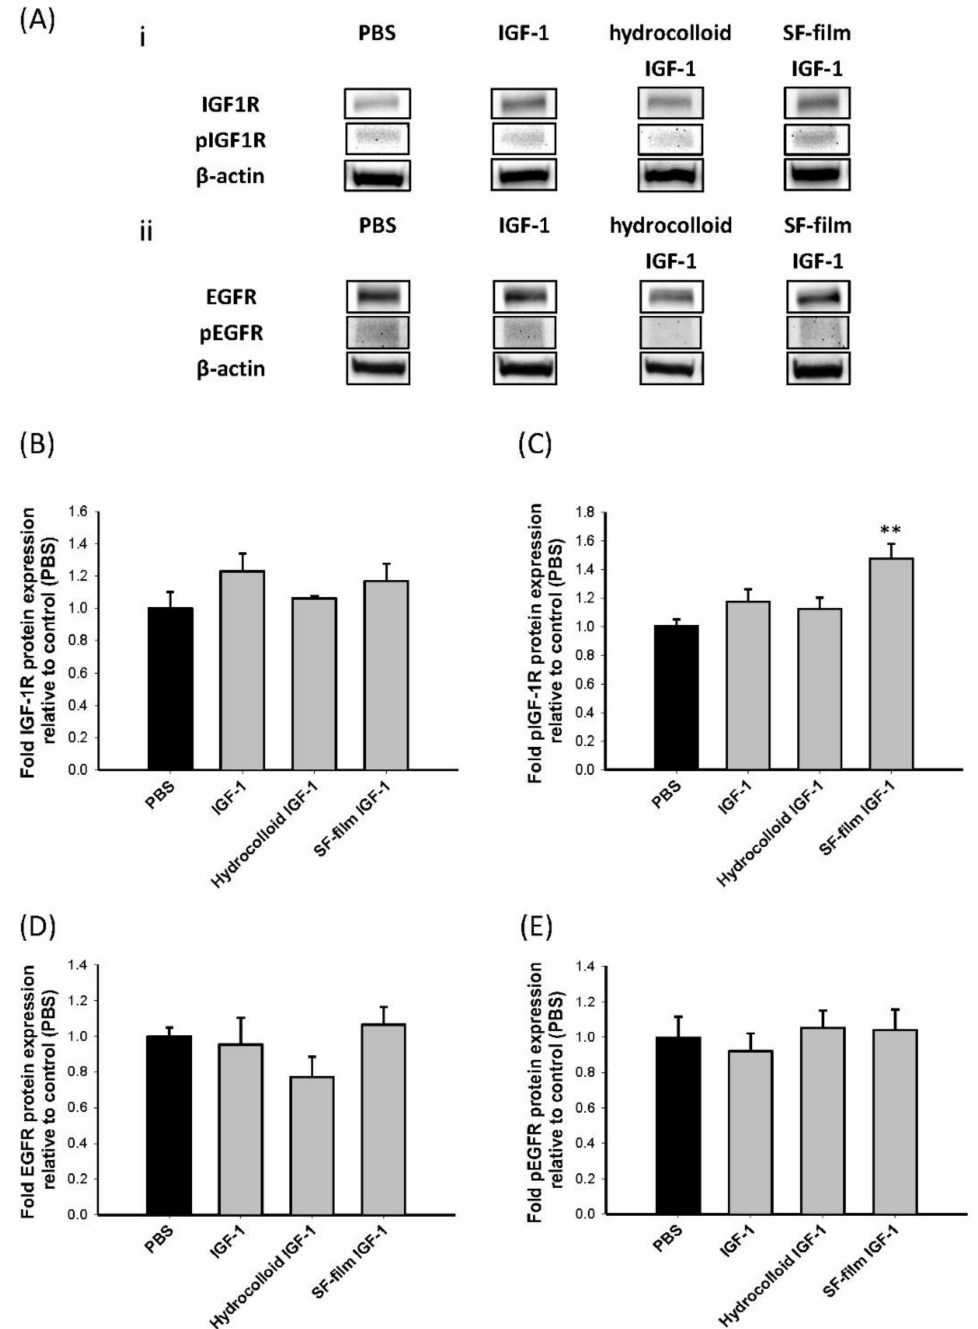
Figure 7. Immunoblotting for insulin-like growth factor type 1 receptor (IGF1R) or epidermal growth factor receptor (EGFR) and phosphorylated IGF1R or EGFR pathway from wound tissues of diabetic mice following treatment with PBS (control), native insulin-like growth factor 1 (IGF- 1), a commercial dressing product (hydrocolloid IGF-1), and IGF-1-loaded SF film (SF film IGF-1) treatments. ( A ) Representative Western blot of db / db mice treated with different treatments 13 days post-wounding. (i) represents IGF-1 receptor (IGF1R) and phosphorylated IGF1R protein expression. (ii) represents EGF receptor (EGFR) and phosphorylated EGFR protein expression. Actin was used as a loading control. Quantification of ( B ) IGF1R protein expression; ( C ) phosphorylation of IGF1R; ( D ) EGFR protein expression; and ( E ) phosphorylation of IGF1R. Significant differences between control (PBS) and other treatments were determined using Dunnett’s multiple comparison post hoc test. ** p < 0.01; n = 5; ±